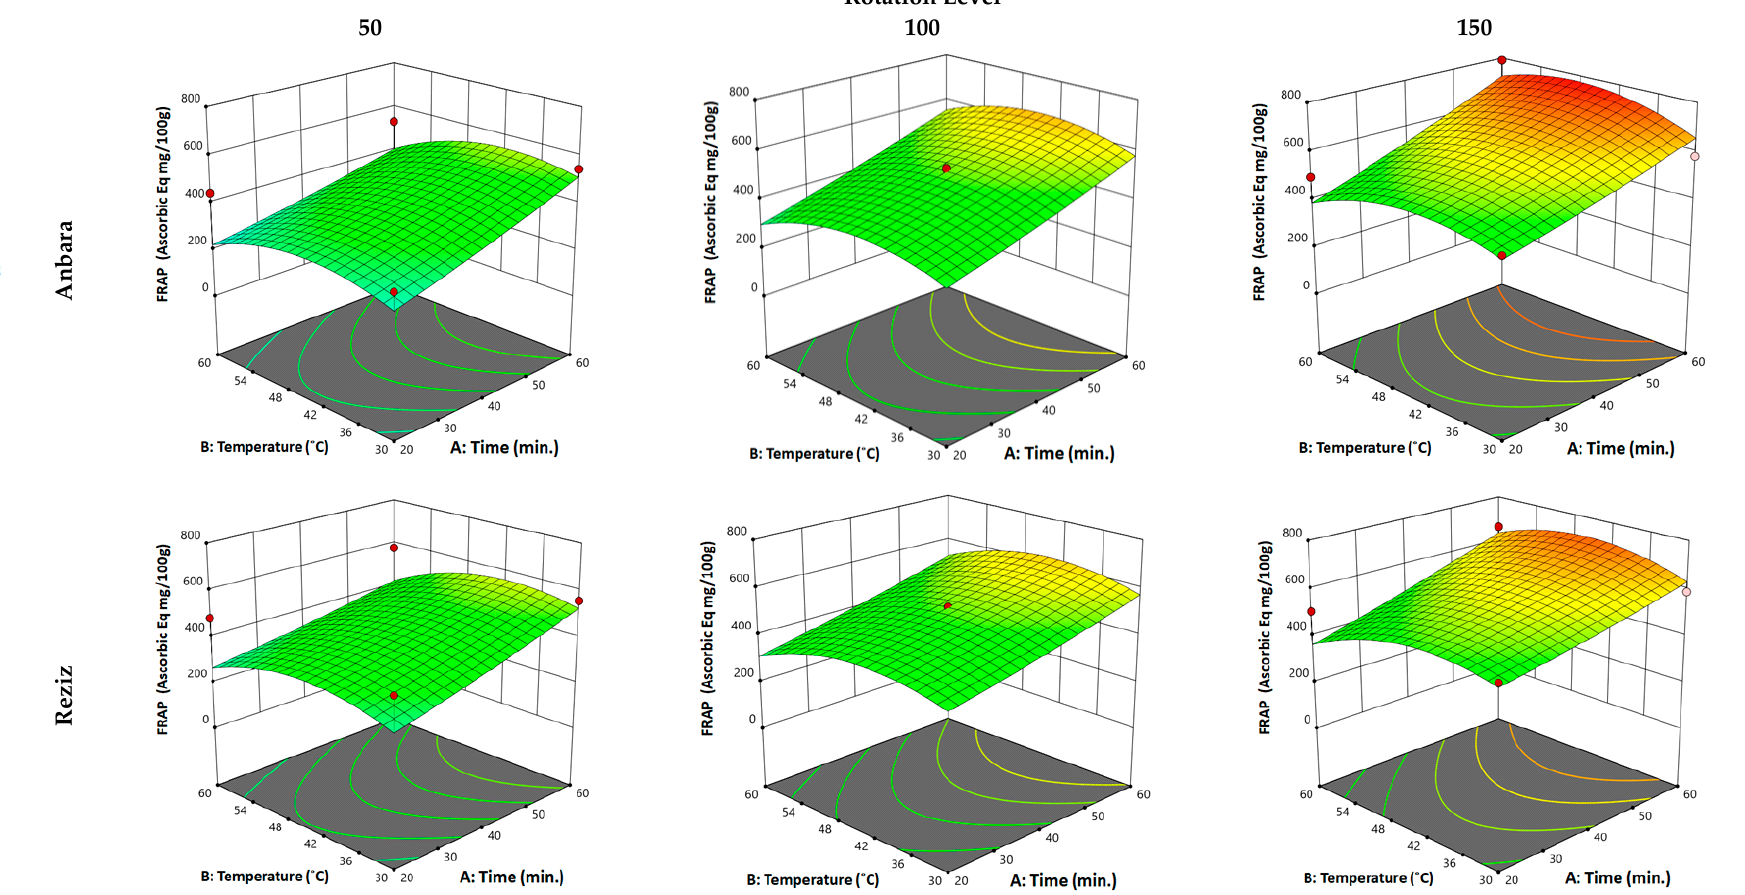
Figure 3. Three-dimensional response surface plot for the “response” variable: (ferric reducing antioxidant power assay (FRAP)), as a function of WAE “factors”: temperature, time, and rotation in two date palm fruits cultivars, Anbara and Reiziz.